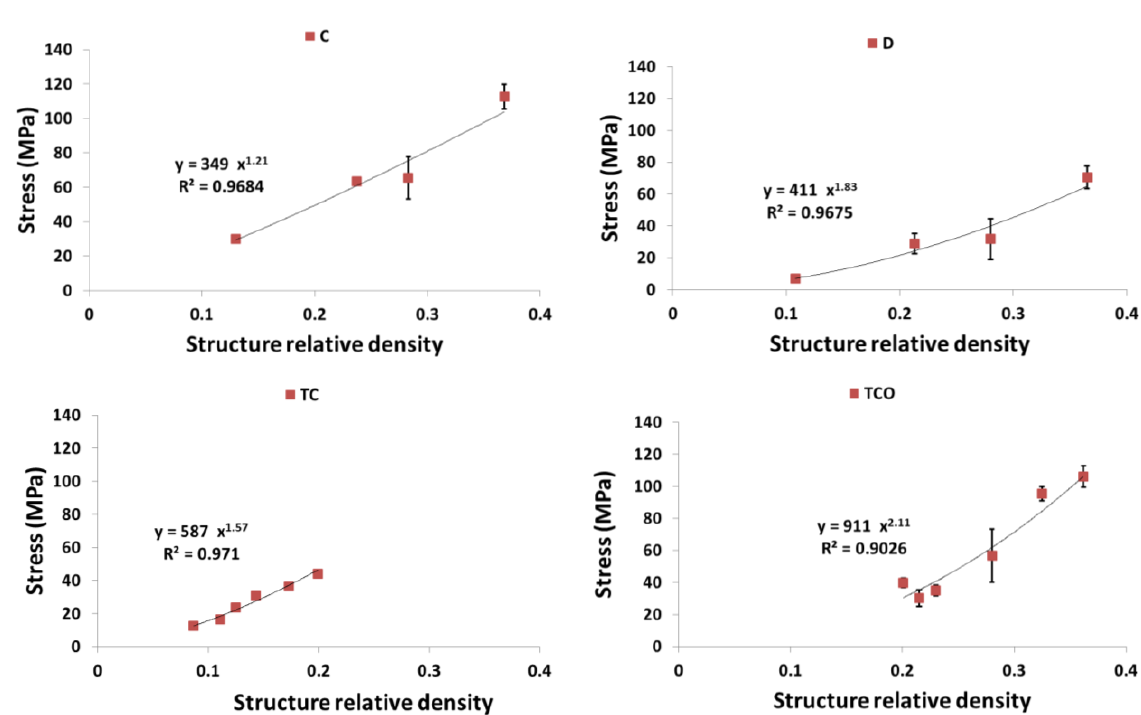
Figure 11. Summary of the plateau stress results for porous structures based on different types of unit cell configurations (cubic (C); diamond (D); truncated cube (TC); truncated cuboctahedron (TCO); rhombic dodecahedron (RD); rhombicuboctahedron (RCO)) and different structure relative densities (see Table